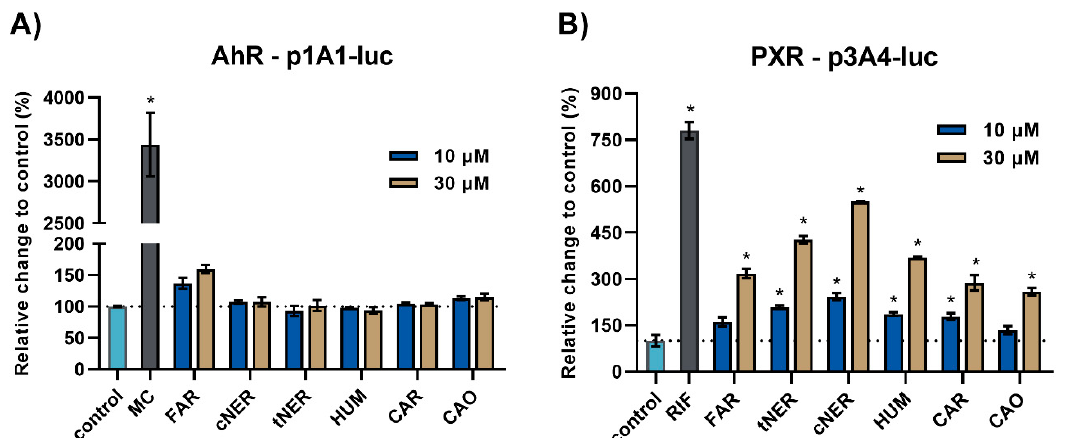
Figure 2. The effect of sesquiterpenes on the AhR and PXR receptors. HepG2 cells were transiently transfected with either p1A1-luc ( A ) or p3A4-luc in combination with expression vectors pSG5-PXR and pSG5-RXR α ( B ). The next day, the cells were treated with the tested compounds for 24 h. AhR and PXR as well as the well-known ligands methylcholanthrene (MC, 10 µM) and rifampicin (RIF, 10 µM) were used as positive controls. The samples were subsequently assayed by a Dual-Luciferase Reporter Assay System (Promega). The results are presented as the relative change to DMSO-treated controls defined as 100% ( n = 3). * p < 0.05.